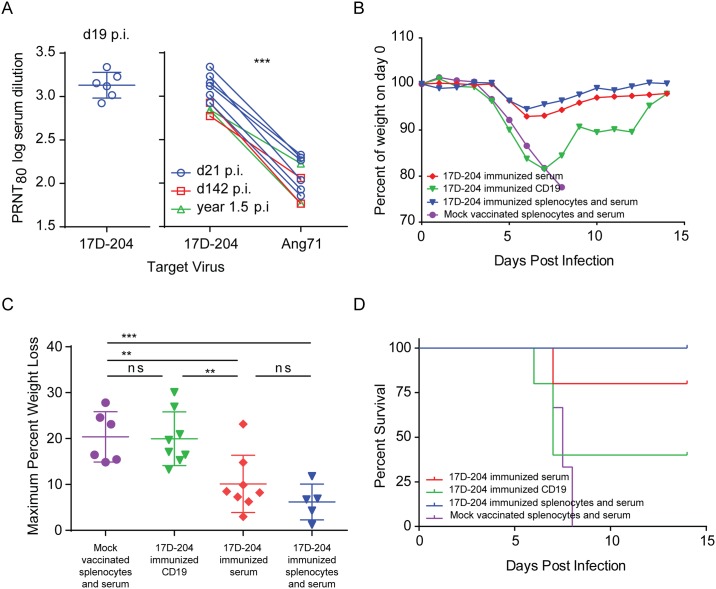
Transfer of convalescent serum or B cells from 17D-204 immunized mice to naïve mice partially protects against challenge with wtYFV.5–6 week old mice were immunized s.c. with 17D-204. (A) serum was harvested and screened by PRNT80 for 17D-204 and Ang71 neutralizing antibody at the indicated days post immunization [***, p = 0.0001 paired t-test]. (B-D) On d21 following immunization, spleens, lymph nodes and sera were collected. CD19+ cells were enriched according to S2 Fig and adoptively transferred into naive 8 week old mice. Some mice received passive transfer of sera and total splenocytes from 17D-204 or mock vaccinated animals. Twenty-four hours after the transfer, mice were challenged with Ang71 and monitored daily for (B) cumulative weight loss (C) maximum weight loss and (D) survival. Weight is expressed as a percentage of weight on d0 of challenge [ns, not significant; **, p≤0.005; ***, p≤0.0005; One-way ANOVA with Tukey's multiple comparisons test]. Refer to Table 1 for statistics comparing percent of survival and numbers of animals. These data are the combined results of two independent experiments.